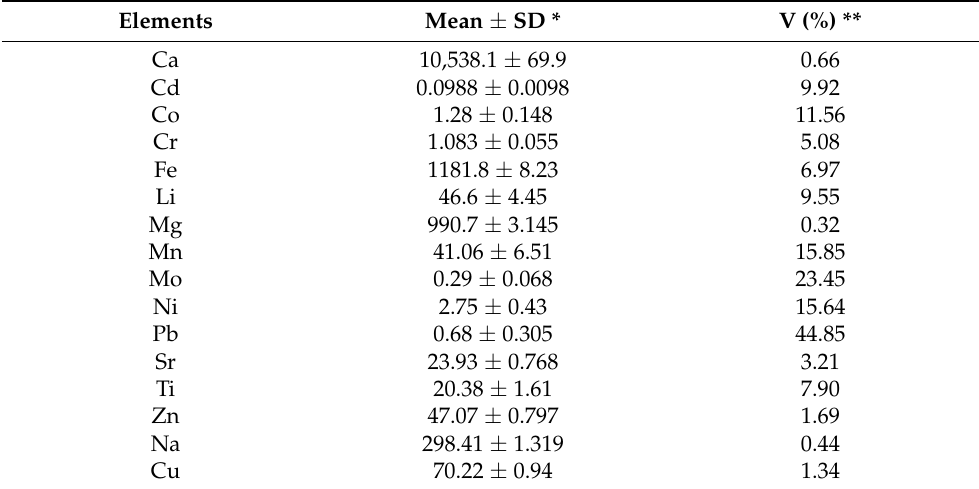
Table 2. Values of mean and standard deviations of chemical elements mass fractions in the plant samples study (mg/kg on a dry mass basis) ( n = 3).